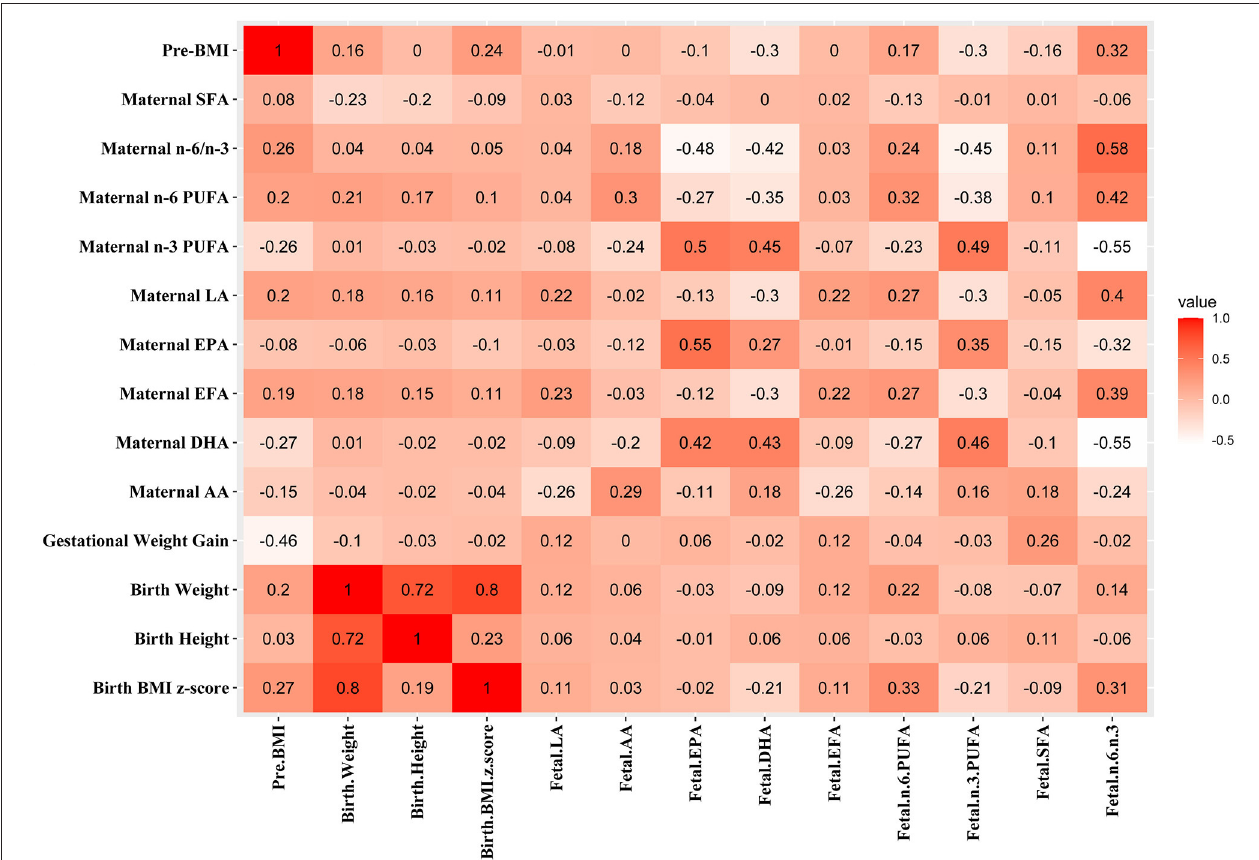
FIGURE 1 | Associations between maternal parameters and fetal parameters. The correlation coefficients are shown in different colors. Red, positive correlation; white, negative correlation.